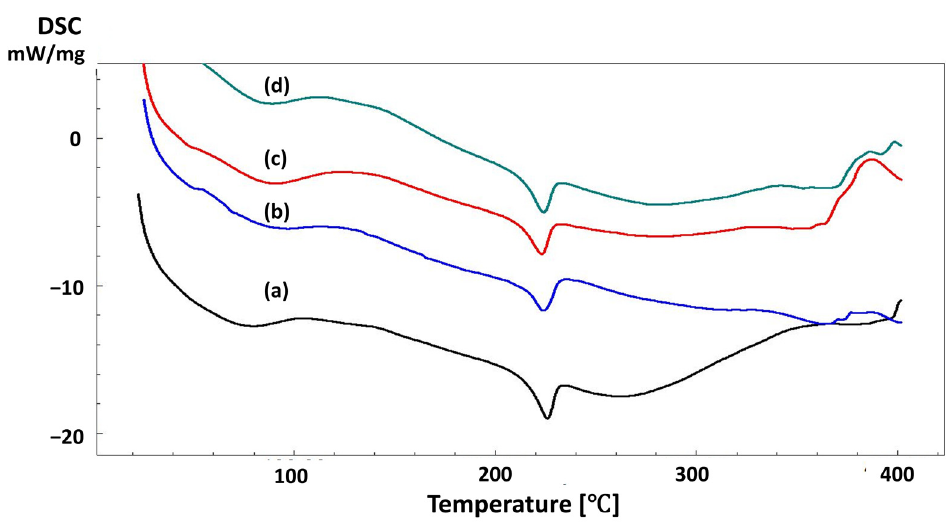
Figure 5. DSC curves of the 13% PVA ( a ), 13% PVA/1% S ( b ), 13% PVA/2% S ( c ), and 13% PVA/3% S ( d ).